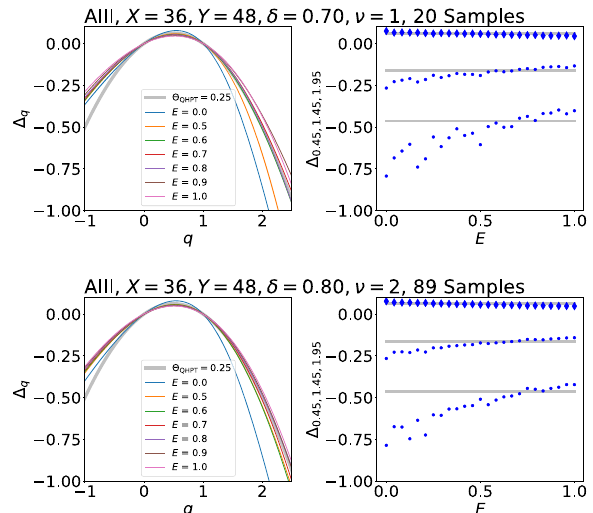
FIG. 11. Disorder-averaged multifractal spectra for the lattice model defined by Eqs. (21) – (26) with surface size L ¼ 48 , slab depth W ¼ 36 , and ν ¼ 1 , 2. The corresponding bulk topological ¯ t 0 ¼ 4 and phases are indicated by the blue dots in Fig. 9, while ¯ Δ ¼ 1 as in Fig. 10. For selected energies, we show Δ q as a function of q in the left-hand panels. The QHPT parabola Δ ð QHPT Þ ≃ ð 0 . 25 Þ q ð 1 − q Þ is shown (thick gray line) for com- q parison. For ν ¼ 1 , 2, selected dimensions Δ are f 0 . 45 ; 1 . 45 ; 1 . 95 g plotted as a function of energy E on the right. As a guide to the eye, Δ ð QHPT Þ ¼ f 0 . 06 ; − 0 . 16 ; − 0 . 46 g are marked by thick f 0 . 45 ; 1 . 45 ; 1 . 95 g gray lines. At zero energy, there is strong multifractality. The gap closes at E ≃ 1 . 5 (not shown) in both cases. The key takeaway is that we observe no even-odd effect: both ν ¼ 1 , 2 exhibit critical surface states (with approximate QHPT multifractality) spanning the bulk energy gap. An even-odd effect would mean critical (Anderson localized) finite-energy states for odd (even) winding numbers. Such an effect is predicted from a naive deformation of the WZNW term in the theory governing zero-energy critical states; see Sec. VII A. The ED studies on the lattice model agree with S -matrix and momentum space (Secs. III, IV) studies in that both ν ¼ 1 , 2 match the QHPT critical behavior at finite